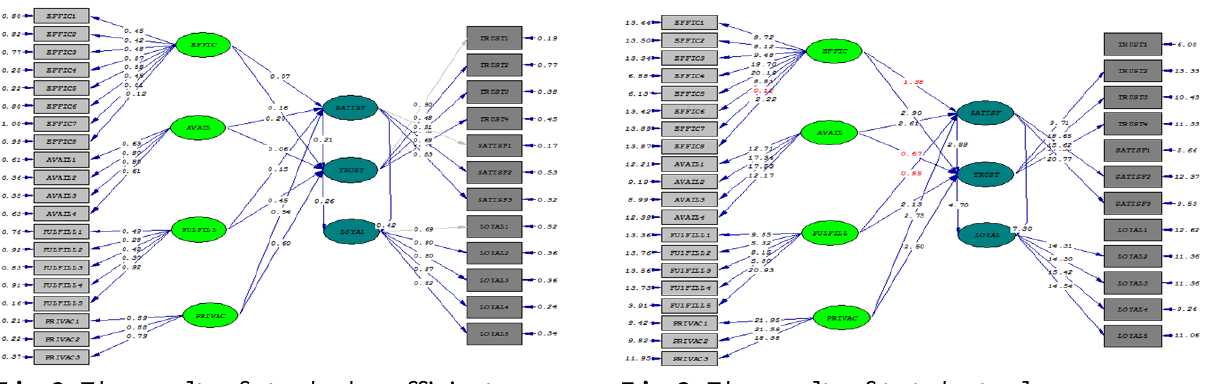
Fig. 2. The results of standard coefficients Fig. 3. The results of t-student